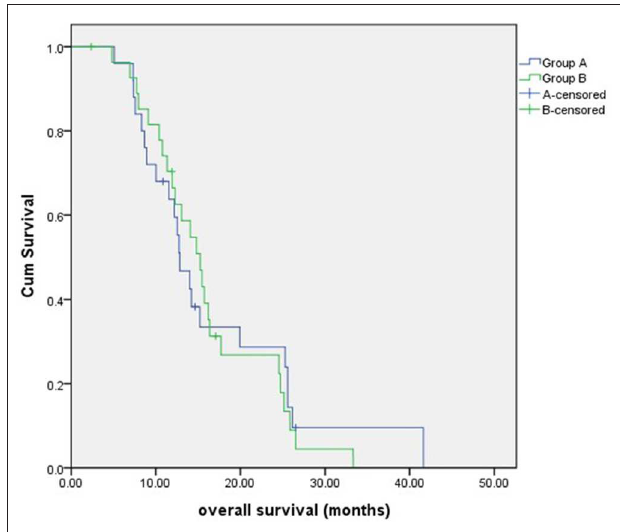
FIGURE 2 | The overall survival of patients in two groups. There was no significant difference between groups A and B.